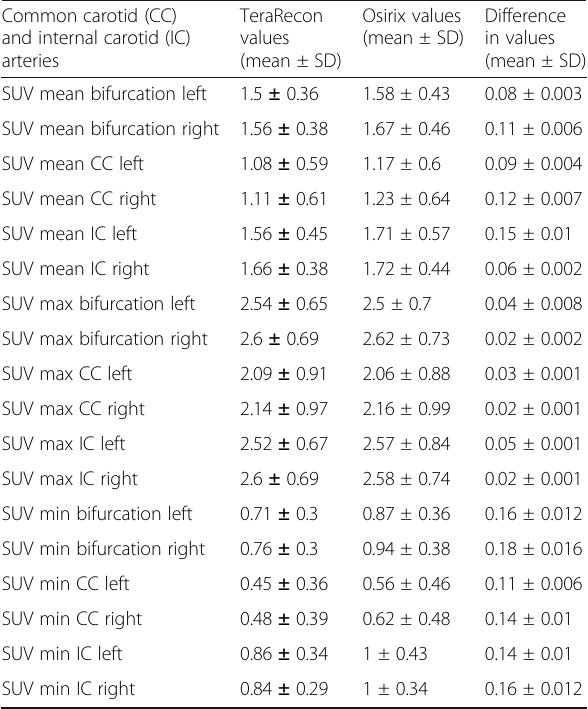
Table 1 SUV measurements (mean and standard deviation) by location and software together with differences (mean